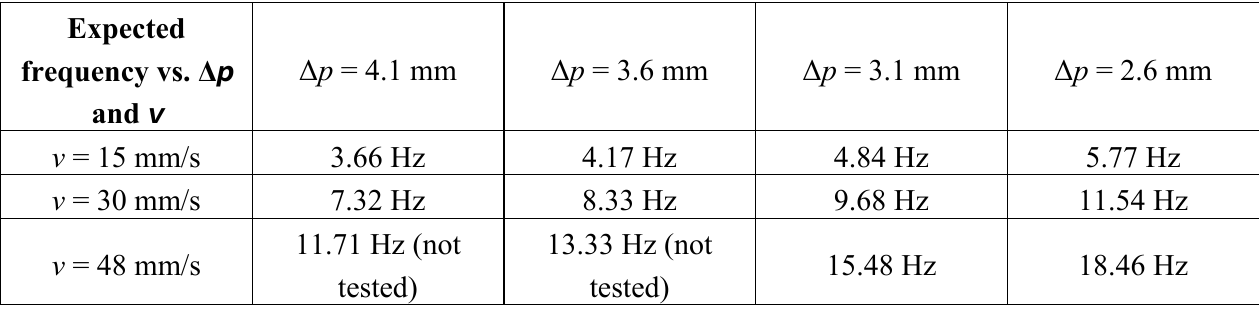
Table 2. Expected principal frequency from sensor outputs depending on the spatial periodicity ( Δ p ) and on the sliding velocity ( v ) of the applied